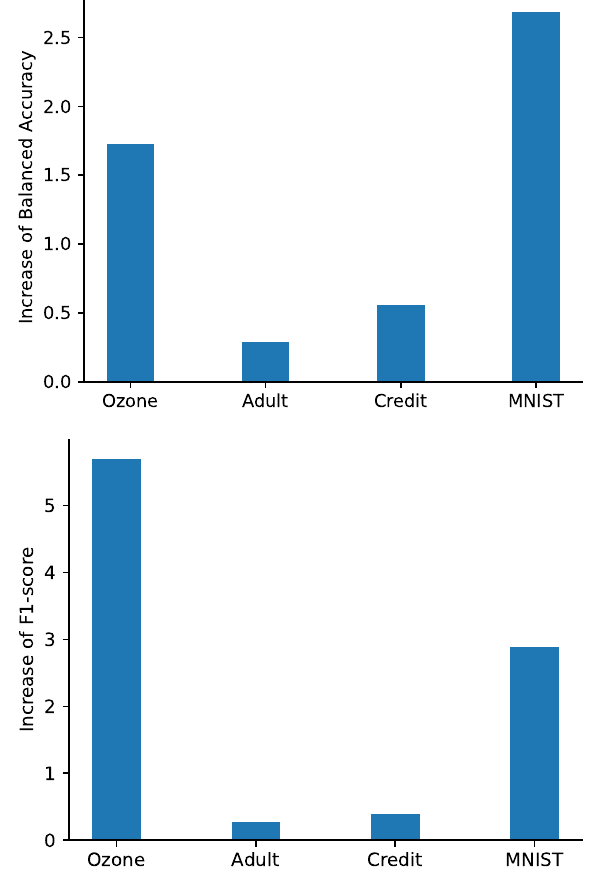
Figure 1. The mean increase in Balanced Accuracy (on the top ) and F1-score (on the bottom ) for the four datasets among all the different data-transformation